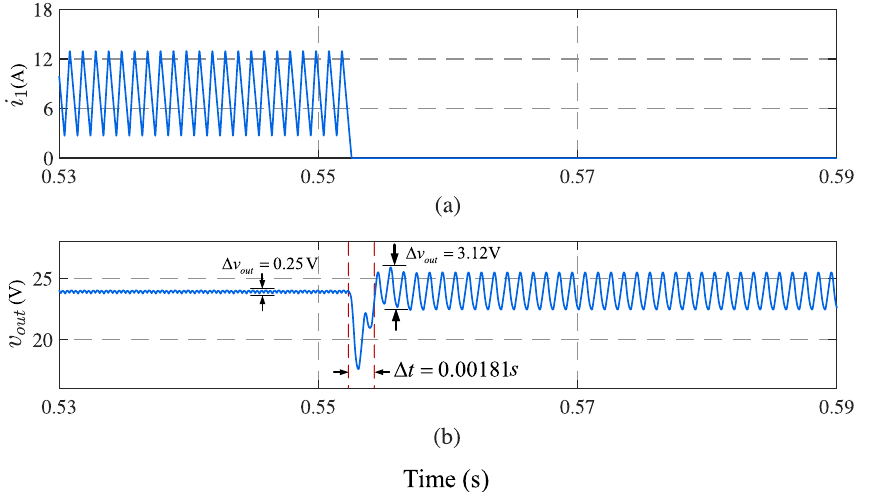
Figure 8. Waveforms after an OCF in branch 1 without the proposed method: ( a ) branch 1 current, and ( b ) the output voltage at load side.